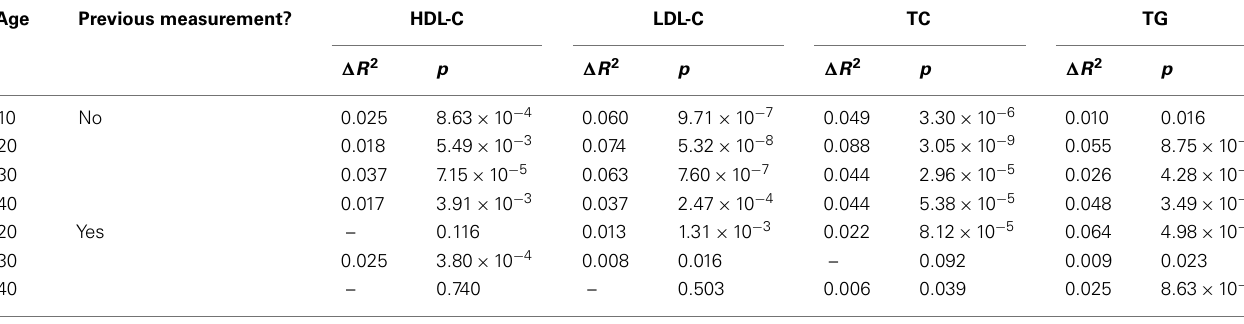
Table 3 | Predictive accuracy of the NCBI risk score for age-specific lipid